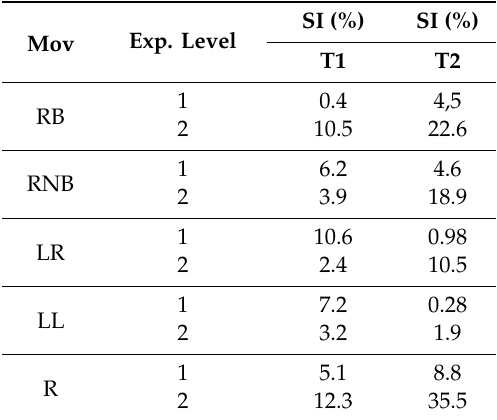
Table 7. Symmetry index for the athletes under all test